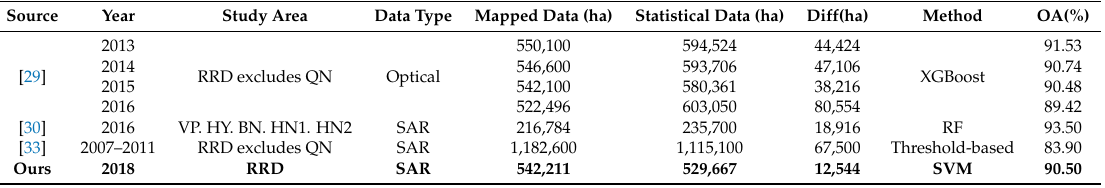
Table 7. A comparison of rice area estimated from related studies in the RRD. QN, VP, HY, BN, HN1, HN2 are abbreviated for Quang Ninh, Vinh Phuc, Hung Yen, Bac Ninh, Ha Noi and Ha Nam,